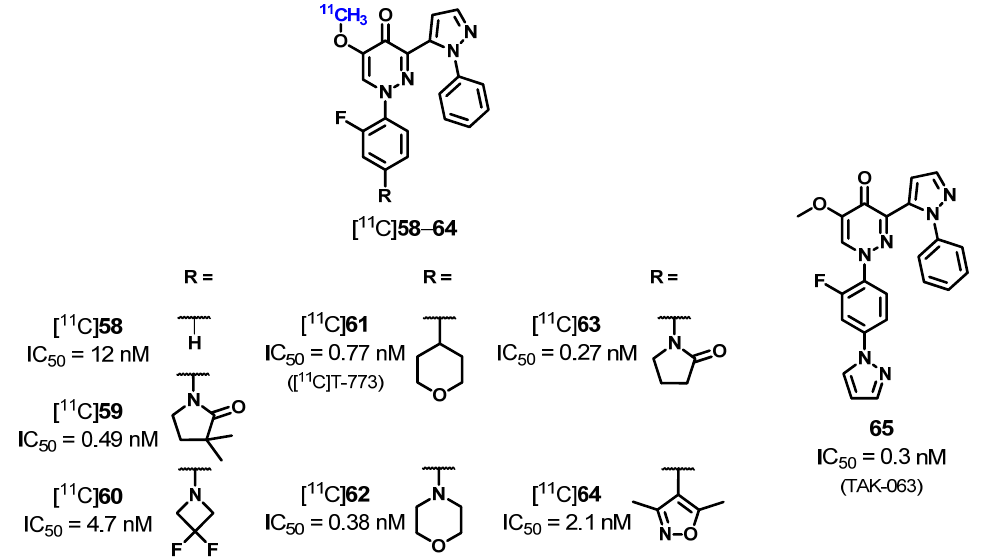
Figure 13. Molecular structures of 11 C-labeled PDE10A radioligands for PET and the PDE10A inhibitor 65